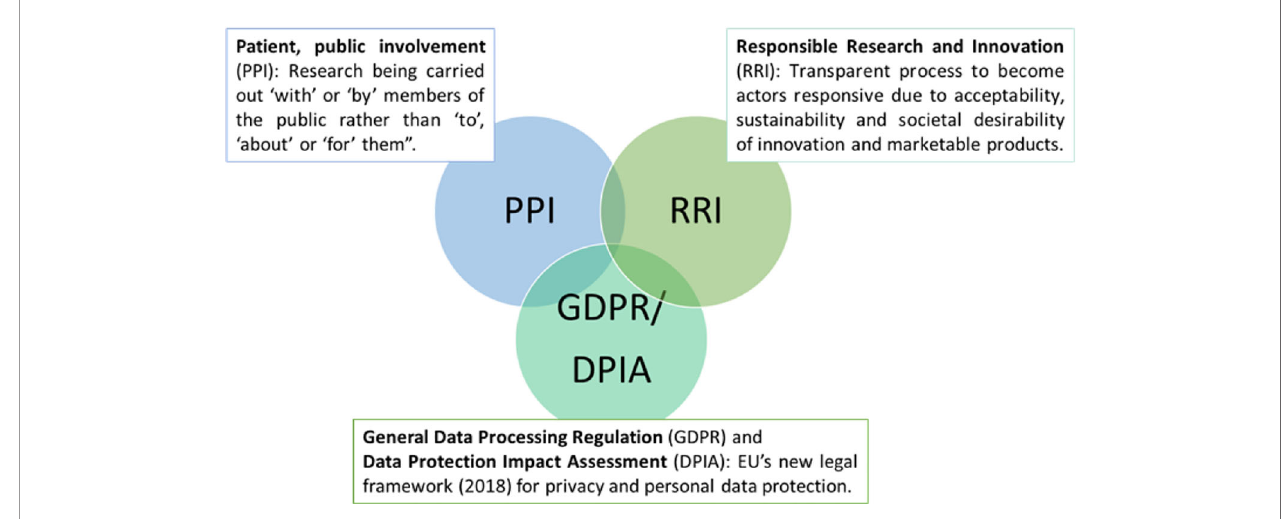
FIGURE 2 | Framework for sustainable ethic in healthcare